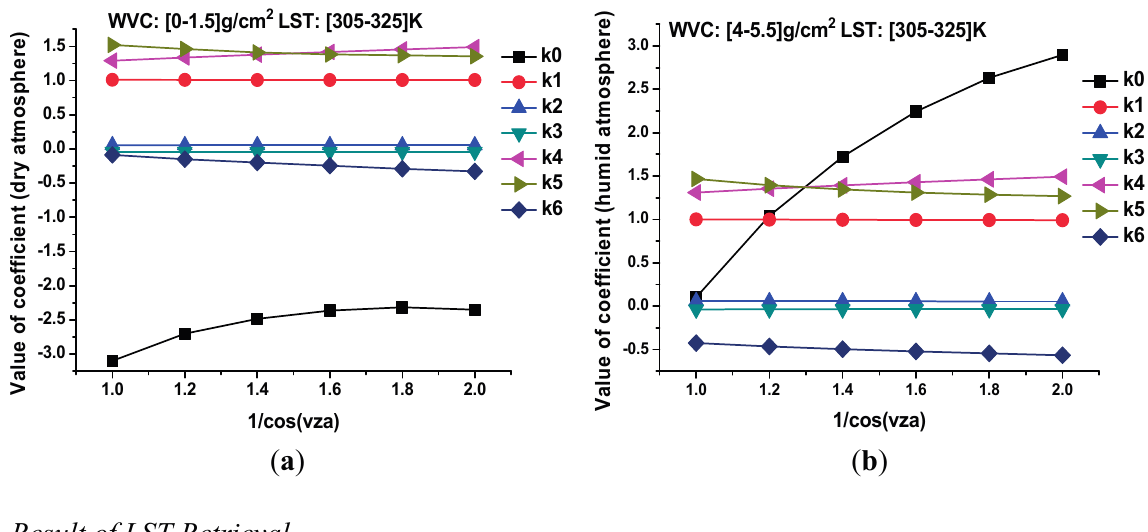
Figure 5. Coefficients for the sub-range with LST varying from 305 K to 325 K.